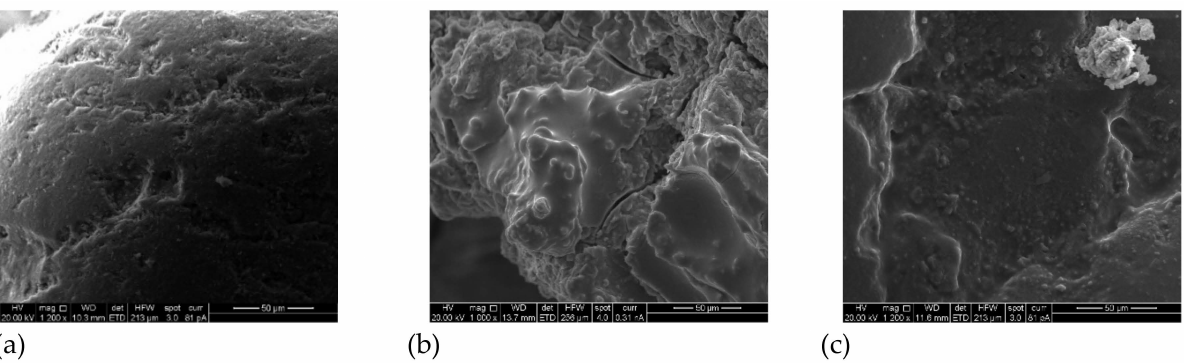
Figure 8. SEM images of ( a ) virgin sand, ( b ) coated sand before sorption, and ( c ) coated sand loaded with tetracycline.